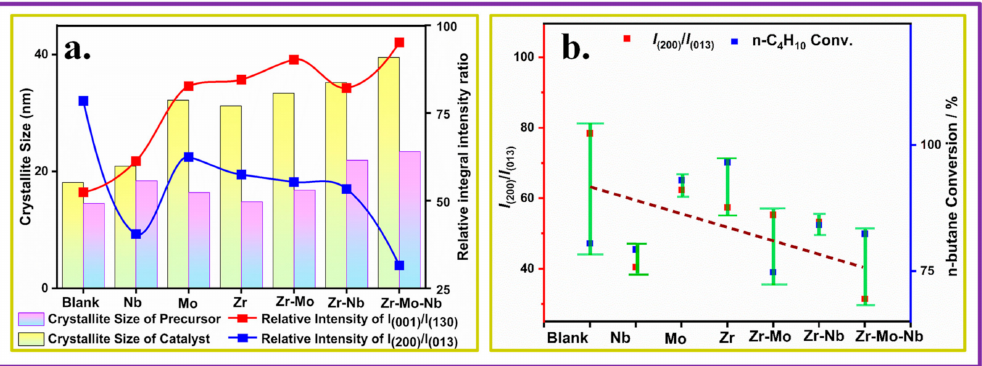
Figure 18. The crystallite size and relative integral intensity ratio of VPO precursors ( I (001) / I (130) ) and catalysts ( I (200) / I (013) ) is depicted using XRD characterization results ( a ); we correlate the relative integral intensity ratio of the VPO catalysts ( I (200) / I (013) ) with their n-butane conversion ( b ).